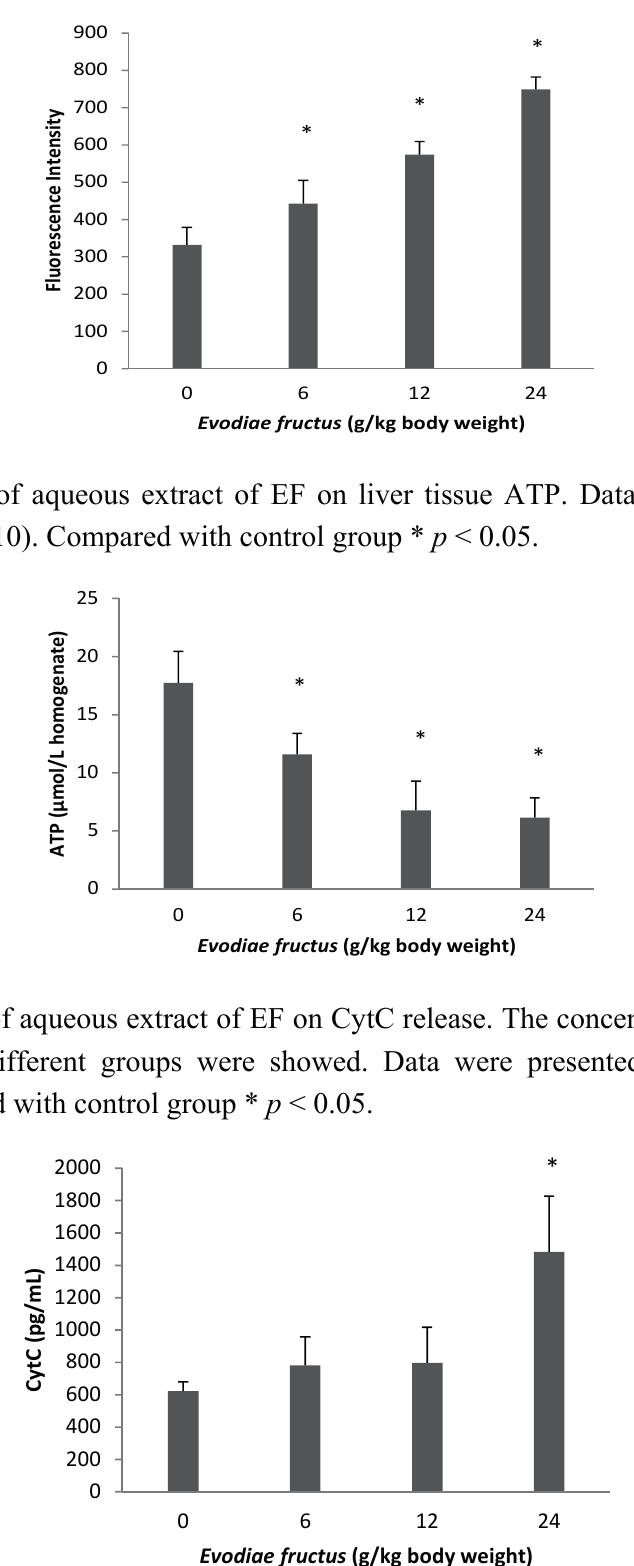
Figure 6. Effects of aqueous extract of EF on mitochondrial transmembrane potential by fluorescence spectrophotometer. The changes of fluorescence intensity of different groups were showed. Data were presented as mean ± SEM (n = 10). Compared with control group * p < 0.05.